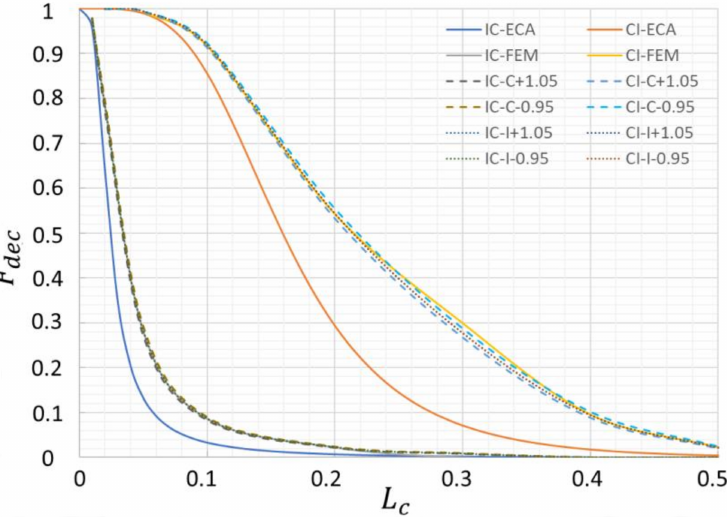
Figure 8. Comparison of the results of FEM model and electrical circuit analogy (ECA) model, where IC corresponds to configuration d and CI to e. Based on the data from [25]: 1.05 means that the curve is derived with property values of the corresponding layer of 1.05 × ( ρ × c p ) and 0.95 to values of 0.95 × ( ρ × c p